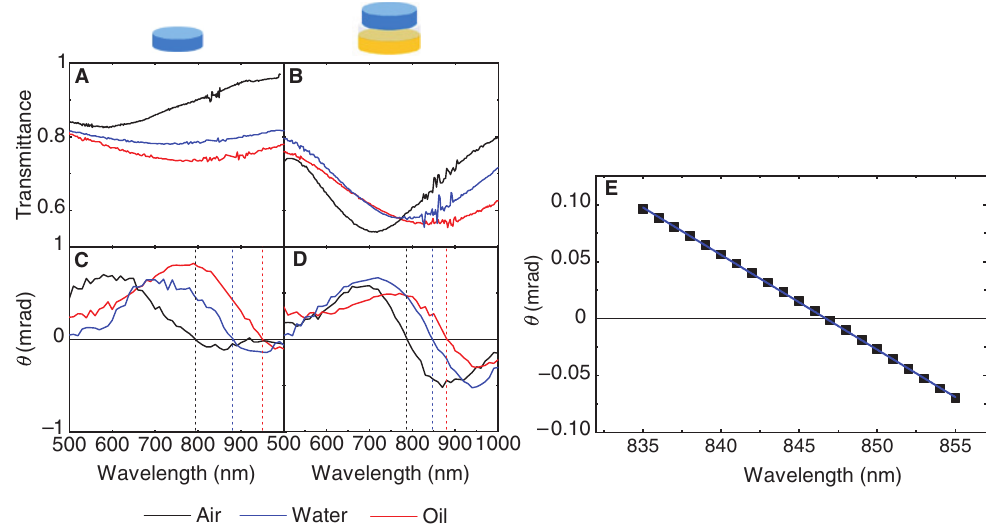
Figure 2: Optical and magneto-optical spectra of single nanoparticles. (A, B) Transmittance and (C, D) Faraday rotation of a random distribution of Ni nanoparticles (left panels) and a random distribution of Ni/ SiO /Au dimers (right panels), measured in air (black curves), water (blue curves), and index matching oil (red curves). The dashed vertical 2 lines in (C) and (D) indicate the Faraday rotation nulling condition for the different dielectric environments. (E) Faraday rotation near the = 847 nm) for Ni/SiO nulling condition ( λ /Au dimers in water. The linear fit to the experimental data gives d θ / d λ = −0.008 mrad/nm. The θ 2 noise level in the Faraday measurements in the spectral range shown is ~ 5 μ rad, i.e. smaller than the square symbols in